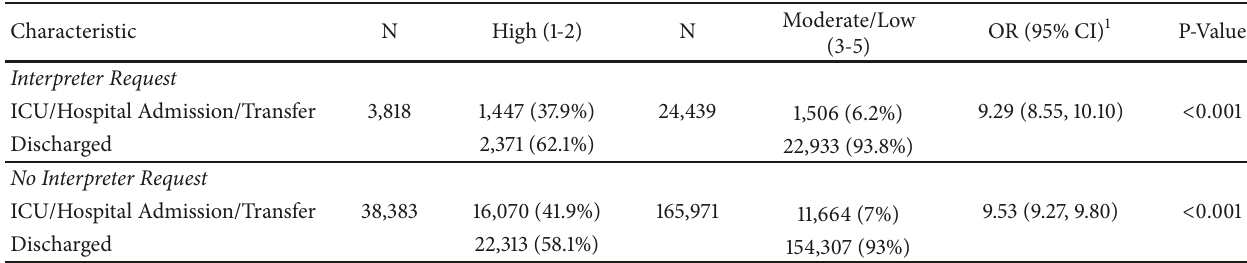
Table 3: Admission rates by acuity and interpreter